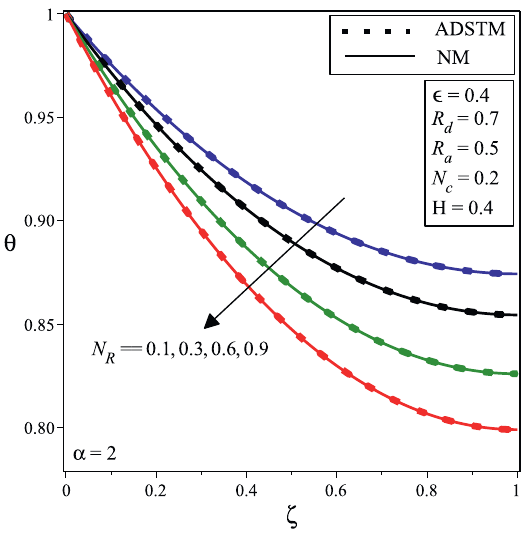
Fig. 2: Effect of surface-ambient radiation parameter, N r and com- parison between the ADSTM with the numerical solution for classi- cal order α =